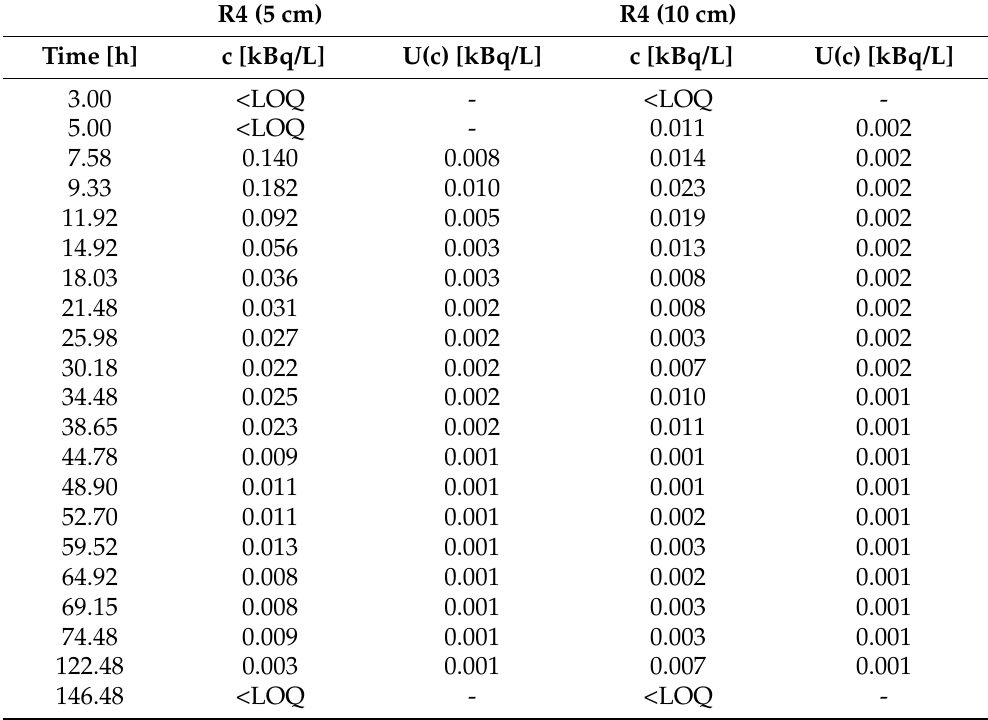
Table A8. Hyporheic 32 P activity concentrations and their analytical uncertainties at point